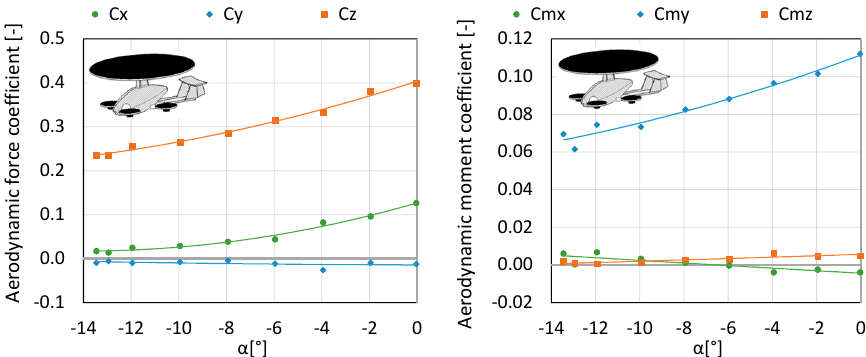
Figure 7. The characteristics of coefficients of forces and aerodynamic moment for configuration K2.